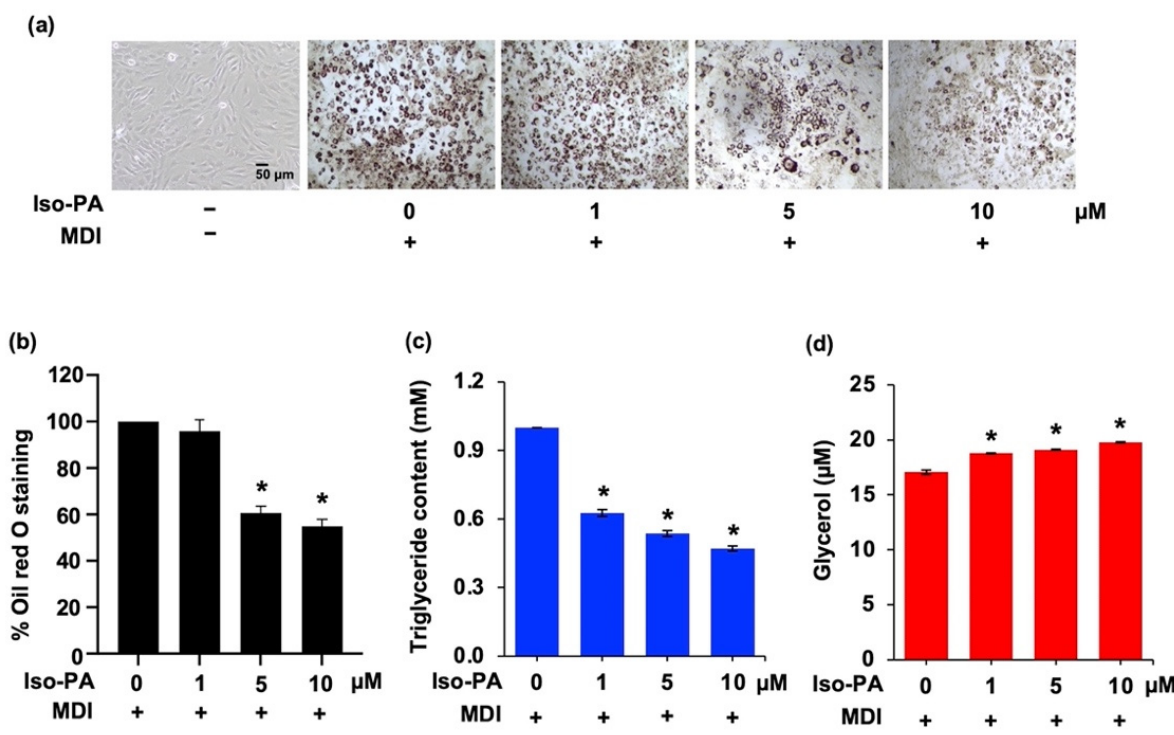
Figure 1. Inhibitory effects of isopanduratin A on the accumulation of intracellular lipids in differ- entiated adipocytes. Mouse preadipocyte 3T3-L1 cells were cultured in differentiation medium in the presence or absence of isopanduratin A at non-toxic concentrations (1–10 μ M). ( a ) The lower number of cellular lipid droplets stained with Oil Red O and ( b ) the relative absorbance of the eluted Oil Red O dye at 500 nm were noticed in differentiated 3T3-L1 cells treated with 5–10 μ M isopan- duratin A for 48 h. The altered levels of ( c ) intracellular triglyceride content and ( d ) extracellular glycerol were initially detected in differentiated 3T3-L1 cells treated with 1 μ M isopanduratin A. Confluent 3T3-L1 cells were cultured in the presence (+) or absence ( − ) of differentiation medium (MDI) with 0–10 μ M isopanduratin A (Iso-PA). Cells treated with dimethyl sulfoxide (0.5% v / v ) functioned as the untreated control (0). Bar graphs demonstrating mean ± SD (n = 3) were created using GraphPad Prism. A one-way ANOVA with Tukey’s post hoc test was used to compare the means of treatment and differentiated control groups (* p < 0.05) .